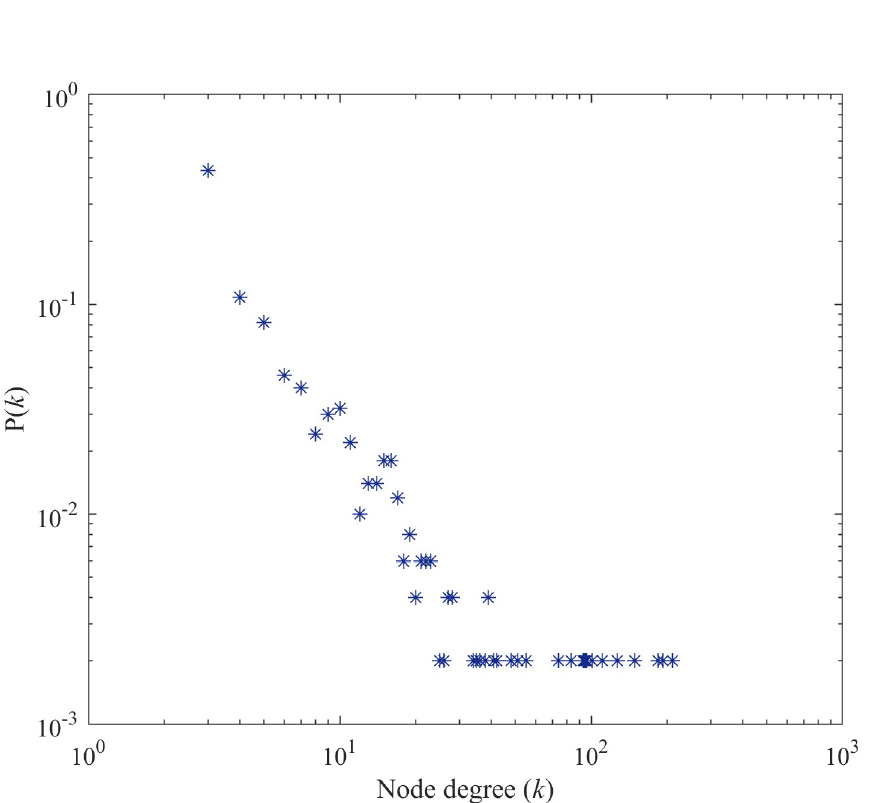
Fig 4. Degree distribution of the SFN. The abscissa represents the node degree value, and the ordinate represents the frequency of the corresponding degree value in the network. The degree distribution of the SFN follows the power-law